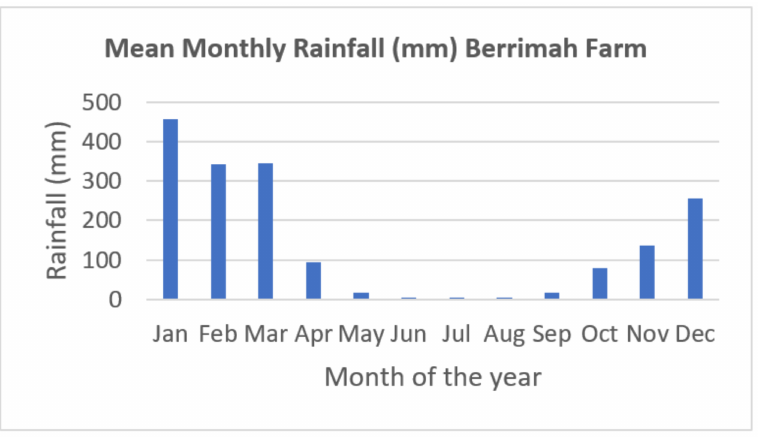
Figure 2. Mean monthly rainfall (mm) at Berrimah Farm (1963–2019) (adapted from [43]). Three species of non-native grasses used in the agricultural industry were represented over five sites: Brachiaria humidicola (Tully grass), Digitaria milanjiana (varieties Jarra Finger grass and Arnhem Finger grass), and Digitaria eriantha (Pangola grass). There were two replicates of B. humidicola and D. milanjiana . The scientific names of these grasses have experienced many botanical name changes, and the current naming conventions used